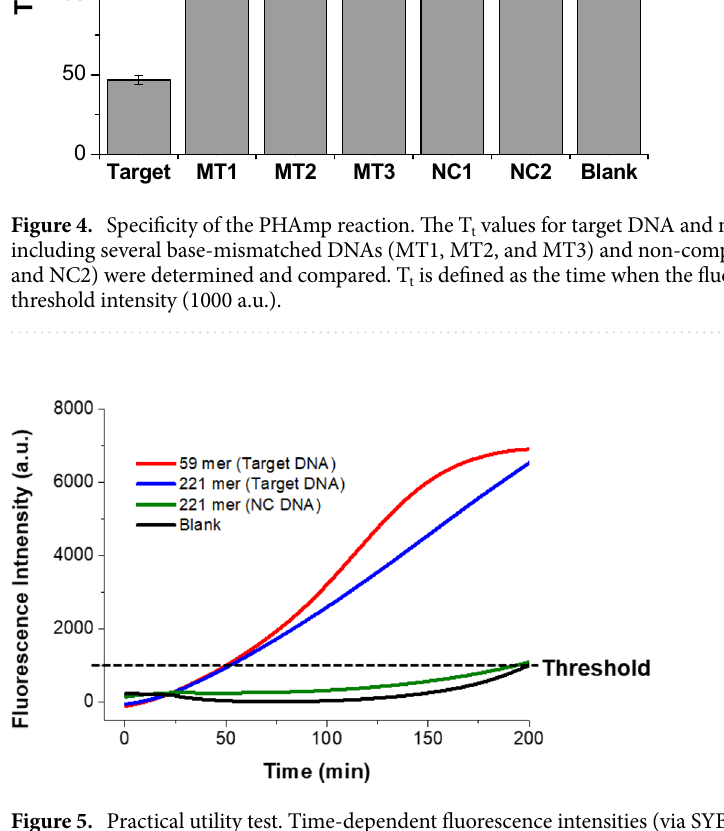
Figure 5. Practical utility test. Time-dependent fluorescence intensities (via SYBR Green I staining) during the PHAmp reaction in the presence of target DNA of different lengths. 221 bp DNAs were obtained from asymmetric PCR and the final concentration of the target DNAs was 20